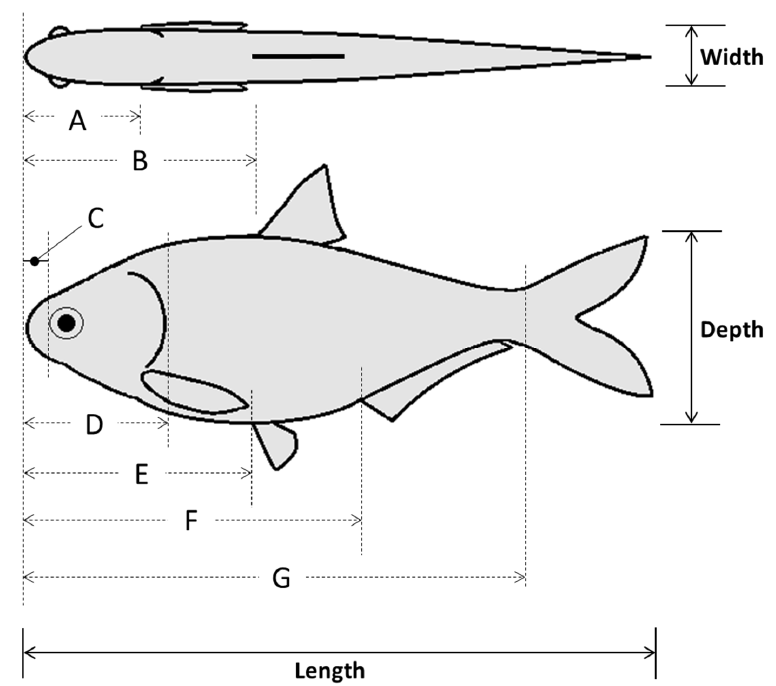
Figure 2. Diagram of major body landmarks from which morphometric measurements were taken related to body length, depth, and width (solid lines). Dashed vertical lines correspond to landmarks including pectoral fin (A), dorsal fin (B), snout (C), head (D), pelvic fin (E), anal fin (F), and caudal fin (G). Horizontal dashed lines represent length measurements between the snout tip and each landmark, while body depth and width measurements were taken on the body at each landmark (i.e., near vertical lines).